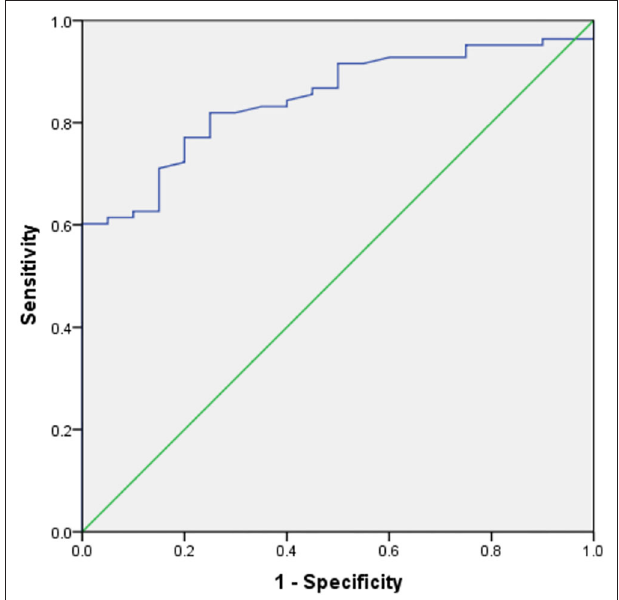
FIGURE 2 | ROC curves for the prediction of DN using serum FPG concentration.